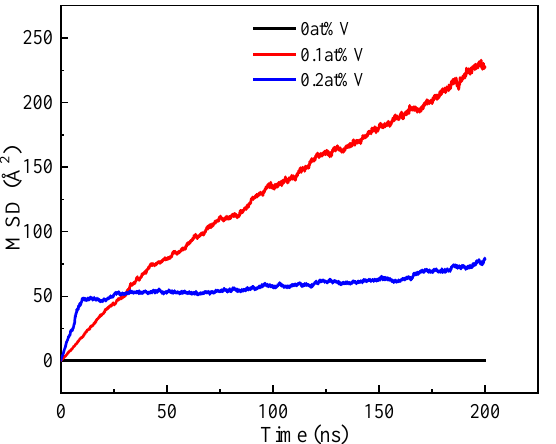
Figure 4. The relationship between MSD (mean-squared displacement) of Cu atoms and time in the Fe-Cu-0V, Fe-3.5Cu-0.1V and Fe-3.5Cu-0.2V alloys after aging at 1050 K for 200 ns.